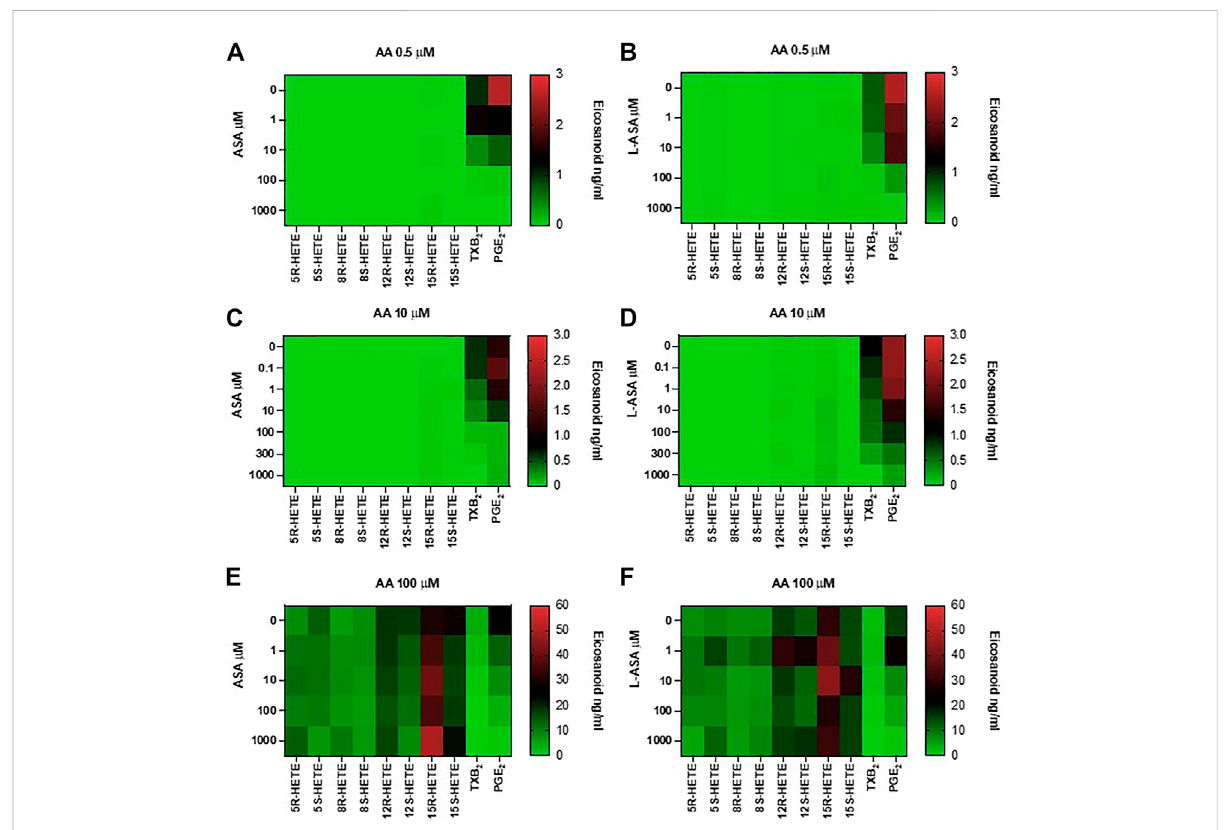
FIGURE 6 EffectsofASAandL-ASAoneicosanoidgenerationinresponsetophysiologicalorhighconcentrationsofAAinHCA7cells.HCA-7cells(1×10 6 ) were treated with DMSO or diluent or increasing concentrations of ASA or L-ASA for 30 min at 37 ° C, then AA 0.5 (A,B) , 10 (C,D) , or 100 μ M (E,F) was added,andtheincubationwascontinuedforfurther30 min.ProstanoidsandHETEswereassessedintheconditionedmediumbyLC-MS/MS.Aheat map of the effect of ASA and L-ASA on eicosanoids biosynthesis (mean values of 4 separate experiments) is shown; results are reported as